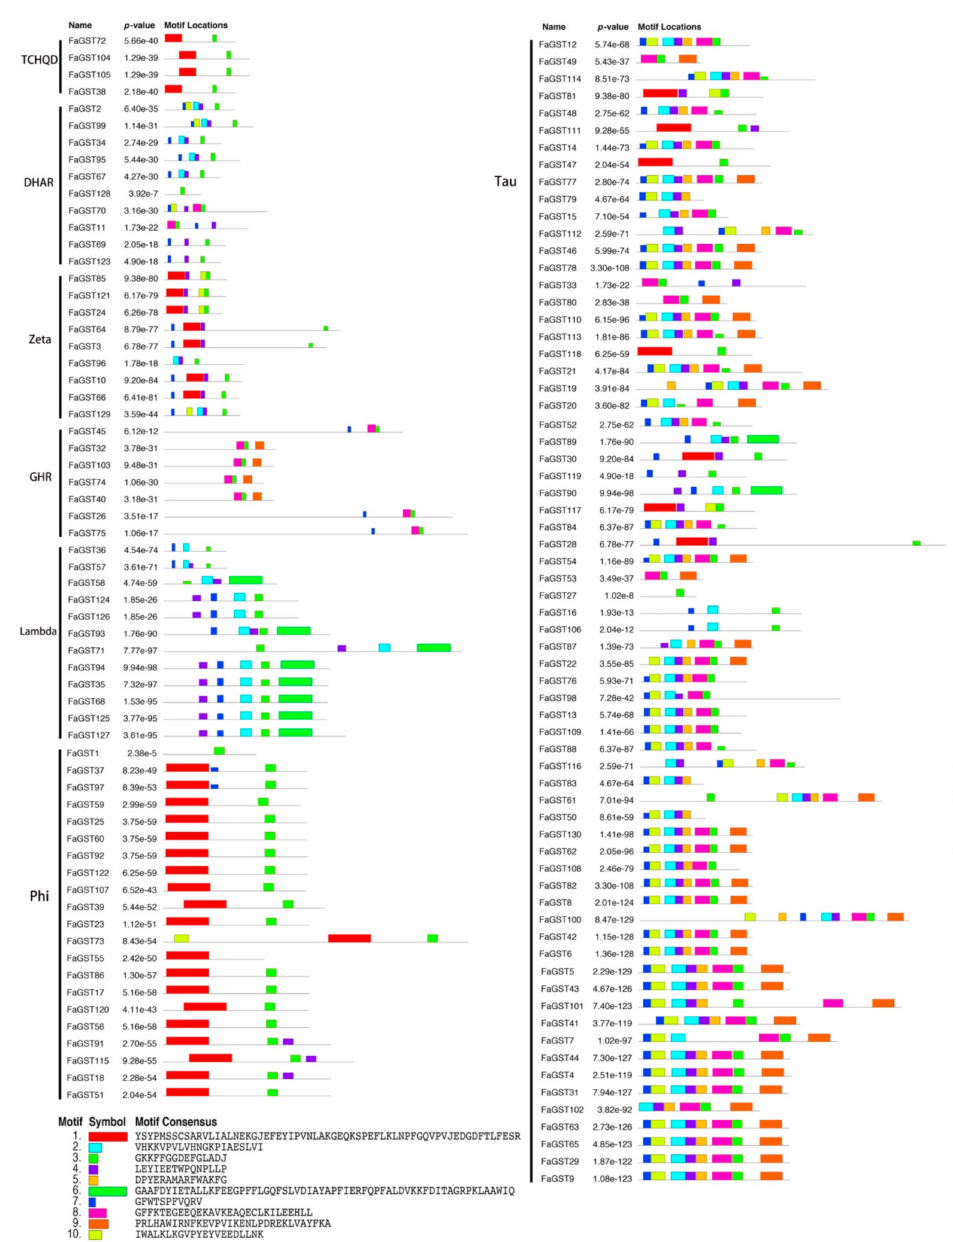
Figure 4. Distribution of the conserved and potential motifs of FaGST proteins. Each motif is represented by colored rectangular box. The core sequence and number of each motif is shown in the black